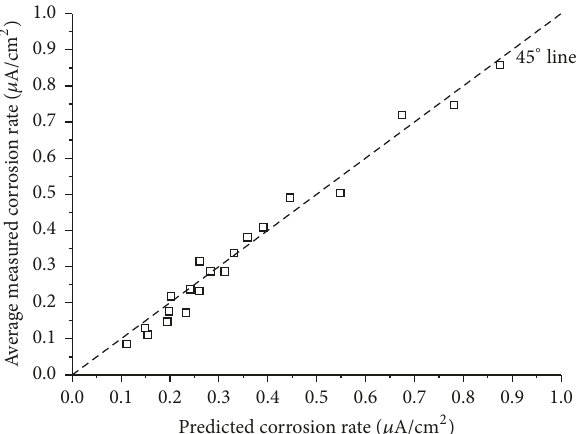
Figure 8: Predicted versus actual measured corrosion rates of cracked specimens.